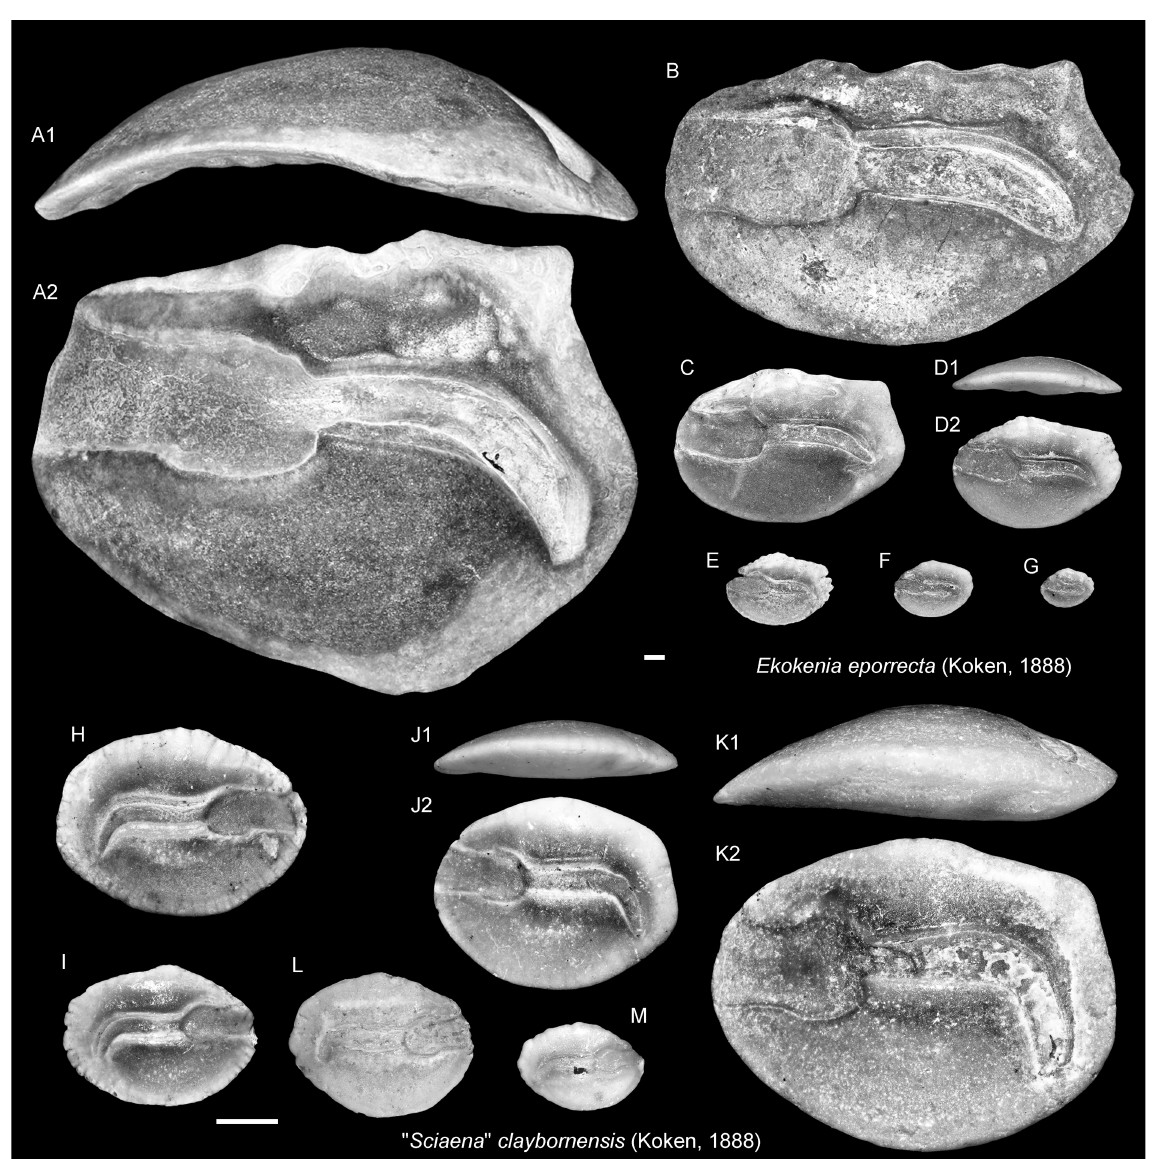
Fig. 32. Fish otoliths from the US middle and upper Eocene. A–G . Ekokenia eporrecta (Koken,